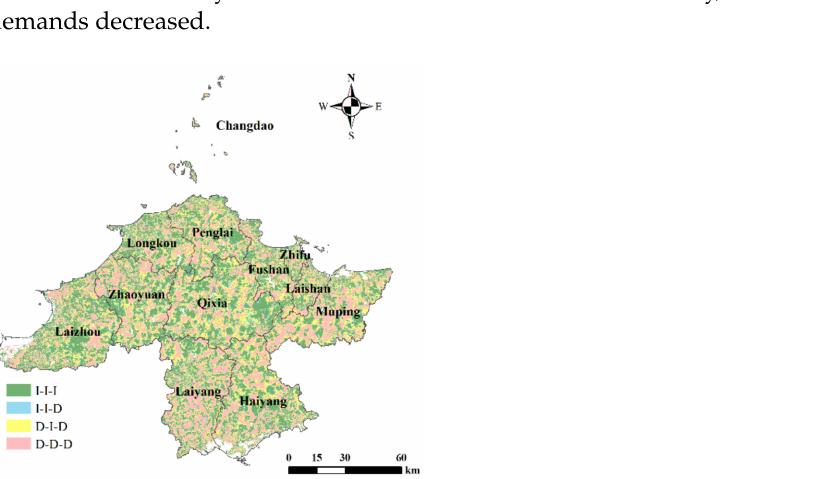
Figure 11. Spatial distribution of combination types of changes in ecosystem services demands from 2009 to